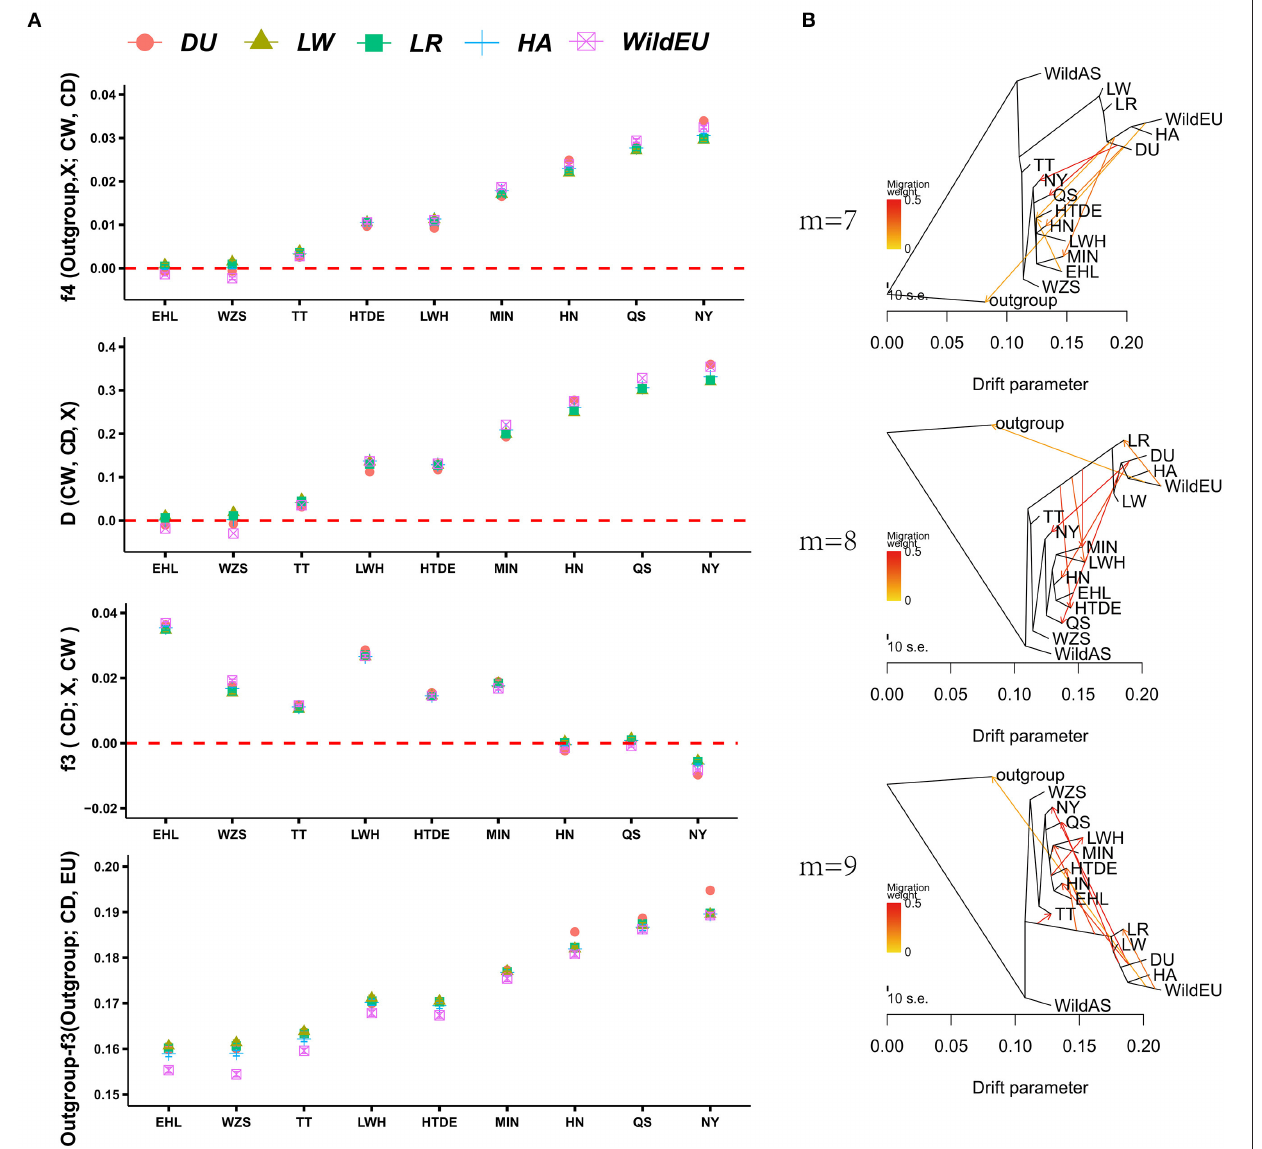
by the sliding-window method. After Z-transformation, ( Figure 3 , Supplementary Table 2